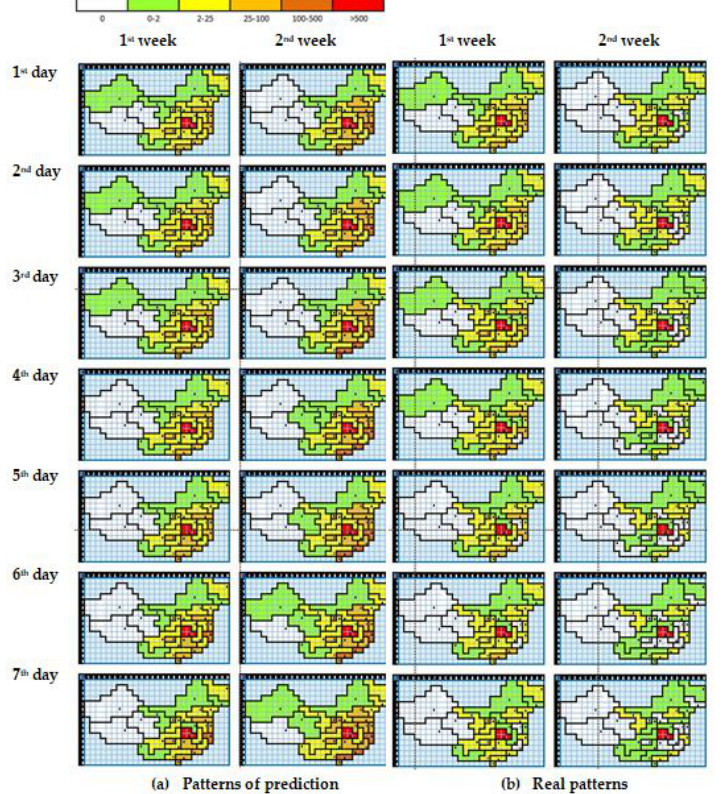
Figure 10. The pattern prediction result for two weeks ( a ) and the real cases ( b ) for the next 14 days (9th week and 10th